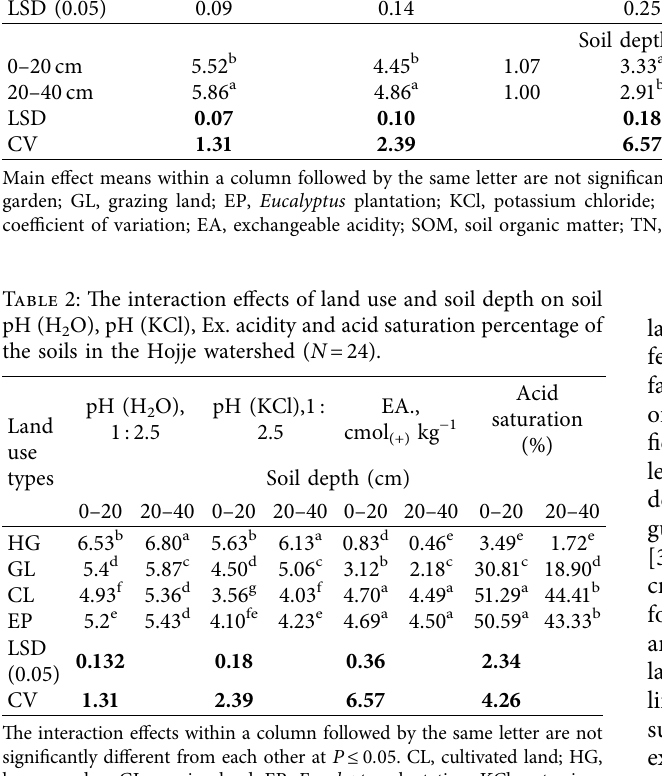
2 O), pH(KCl), Ex. acidity, acid saturation percentage, SOM, TN, and aval P of